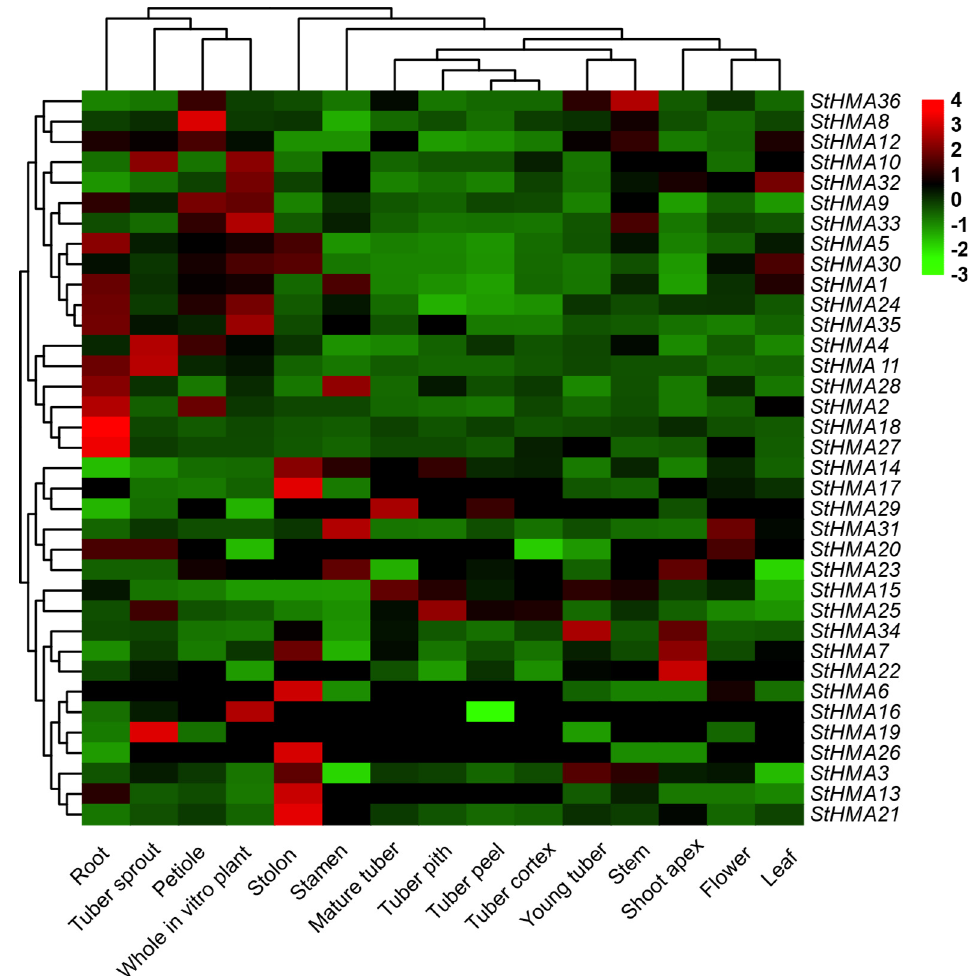
Figure 7. Tissue-specific expression profiles of StHMA genes in di ff erent Solanum tuberosum organs. The transcription levels of StHMA genes in di ff erent tissues. Heatmaps were generated using the TBtools (Toolbox for biologists V.1.046) software from the normalized value by row for the signatures in transcripts per million (TPM), and gradient color from green to red was transcript levels of each StHMA gene. StHMA family were acquired from the gene expression profiles database (ArrayExpress, https: // www.ebi.ac.uk / arrayexpress) (accession number: E-MTAB-552), are listed in Table S7.